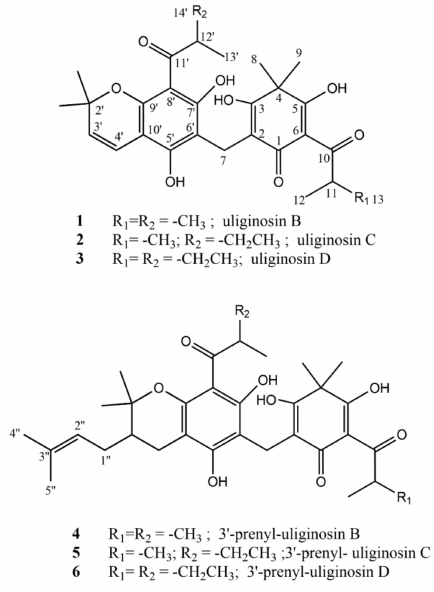
Figure 1. Structural